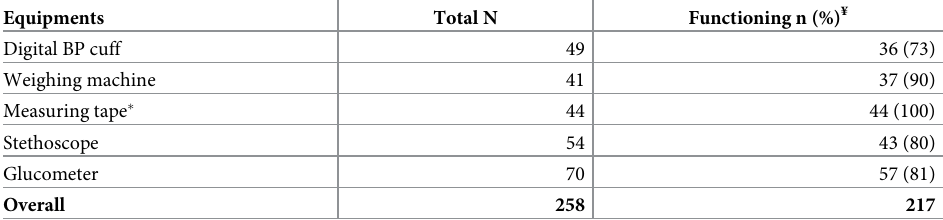
Table 5. Availability of functional equipments at 20 PEN implementing facilities in Myanmar in